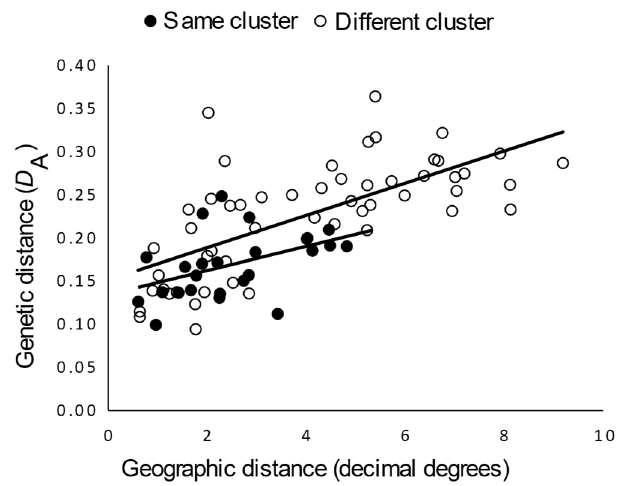
Figure 4. Relationship between Nei’s genetic distance and geographic distance between gray fox ( Urocyon cinereoargenteus ) sampling sites within vs. between genetic clusters ( K = 3). Nei’s genetic distance ( D A ) was estimated from 20 microsatellite loci for each pair of sampling sites (Figure 1), which are indicated as comparisons between sampling sites assigned to the same genetic cluster (open circle) and to different genetic clusters (filled circles). Genetic clusters were defined for each sampling site as the one for which the greatest ancestry ( q value) was assigned in the admixture analysis (see Figure 3). Trend lines illustrate statistically significant relationships based on partial Mantel tests.